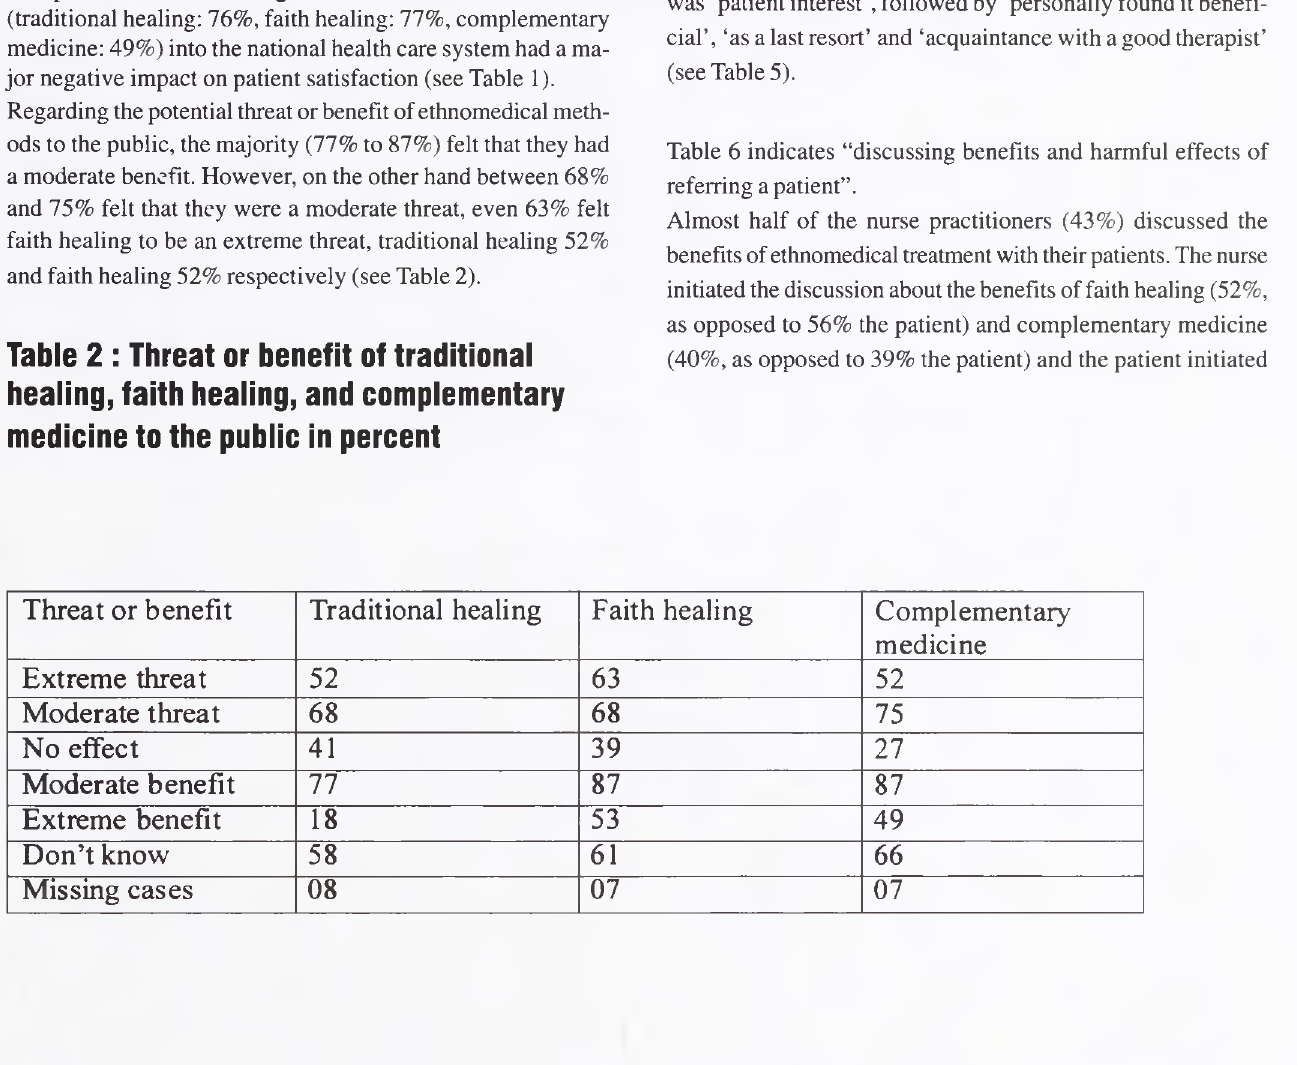
Table 2 : Threat or benefit of traditional healing, faith healing, and complementary medicine to the public in percent